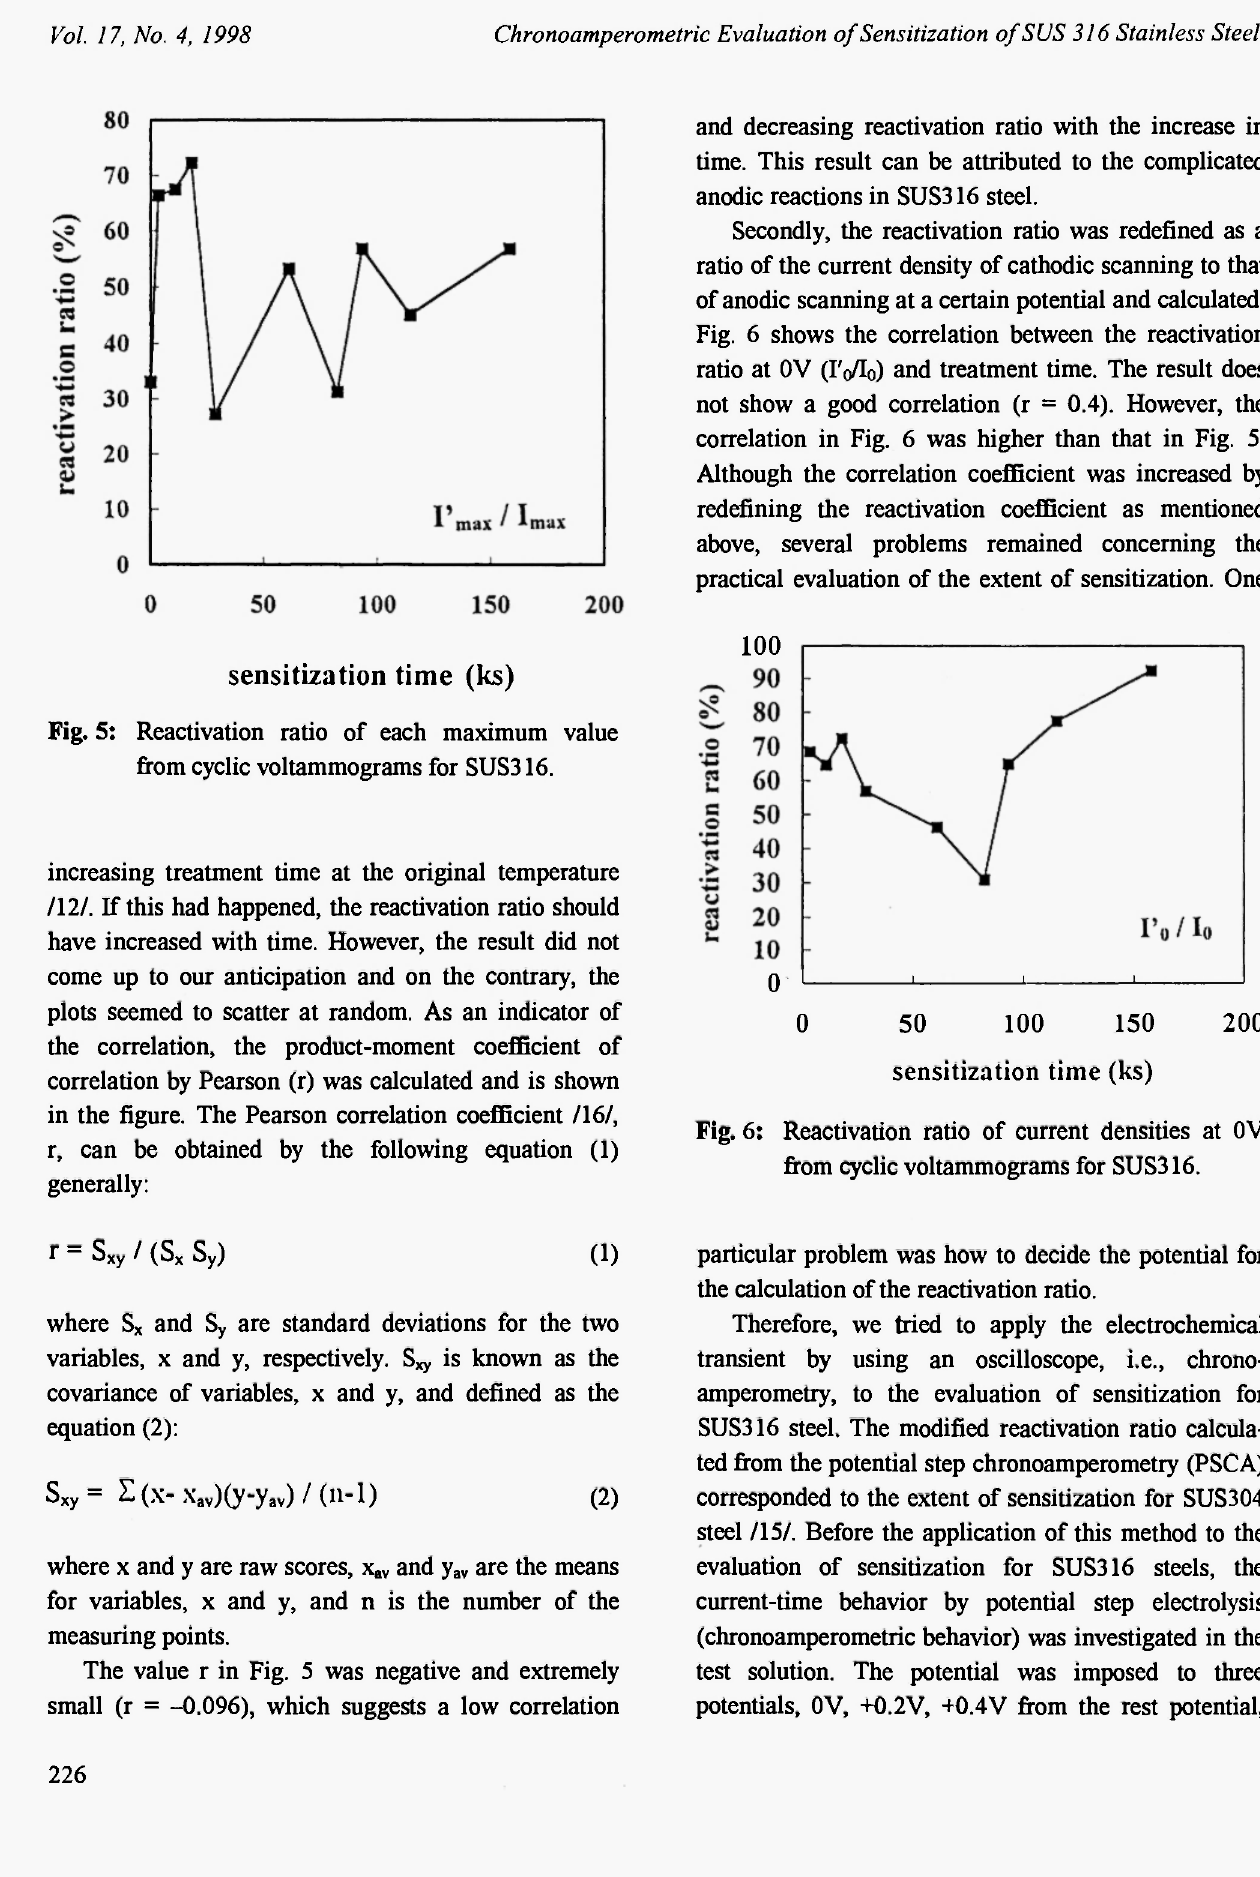
Fig. 5: Reactivation ratio of each maximum value from cyclic voltammograms for SUS316.